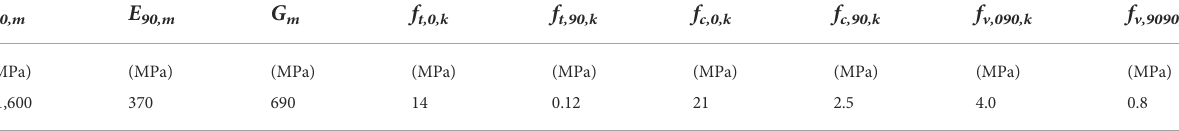
TABLE 3 Mechanical properties of timber members used in the FE